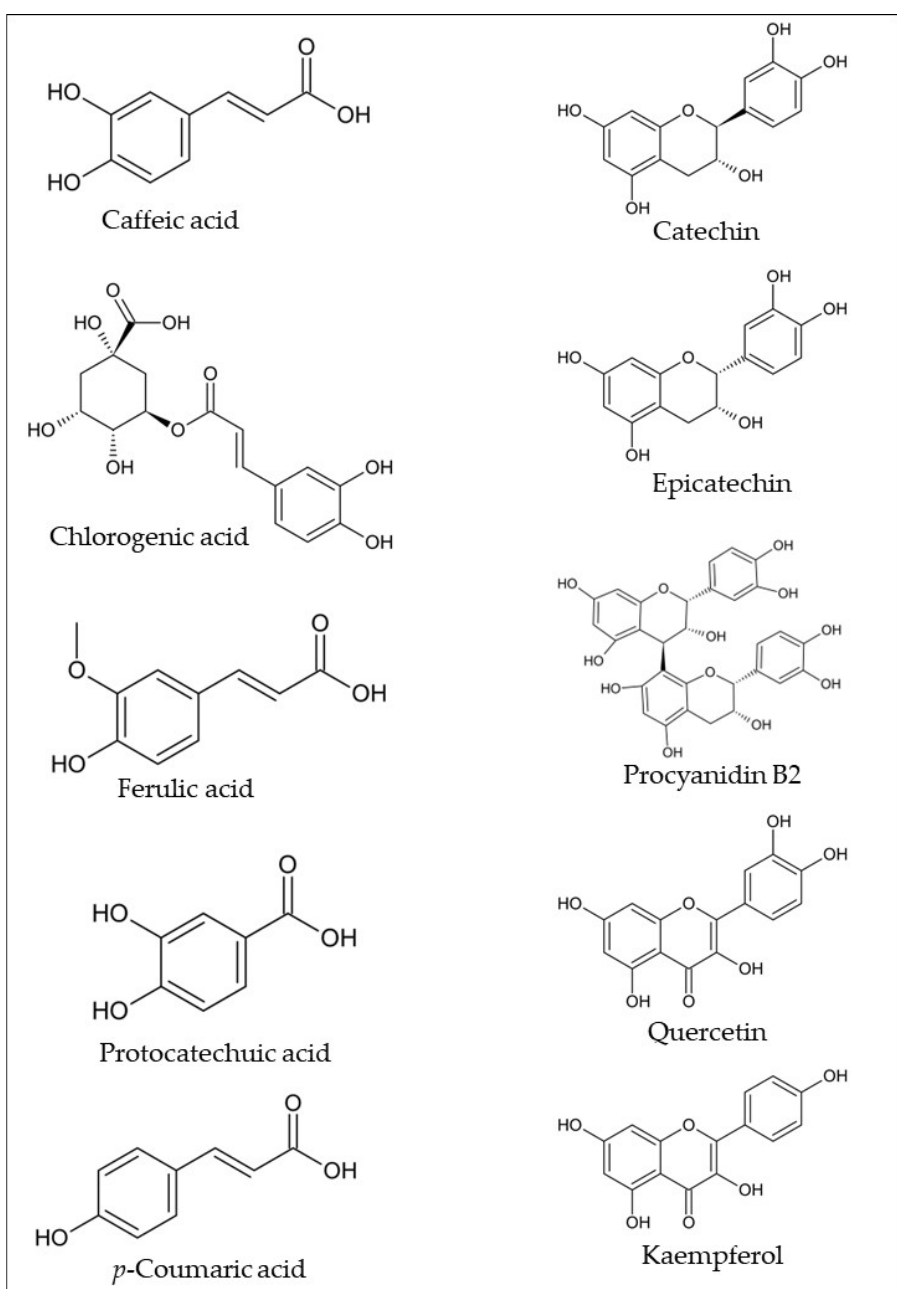
Figure 2. Chemical structures of the most common phenolic compounds found in araticum